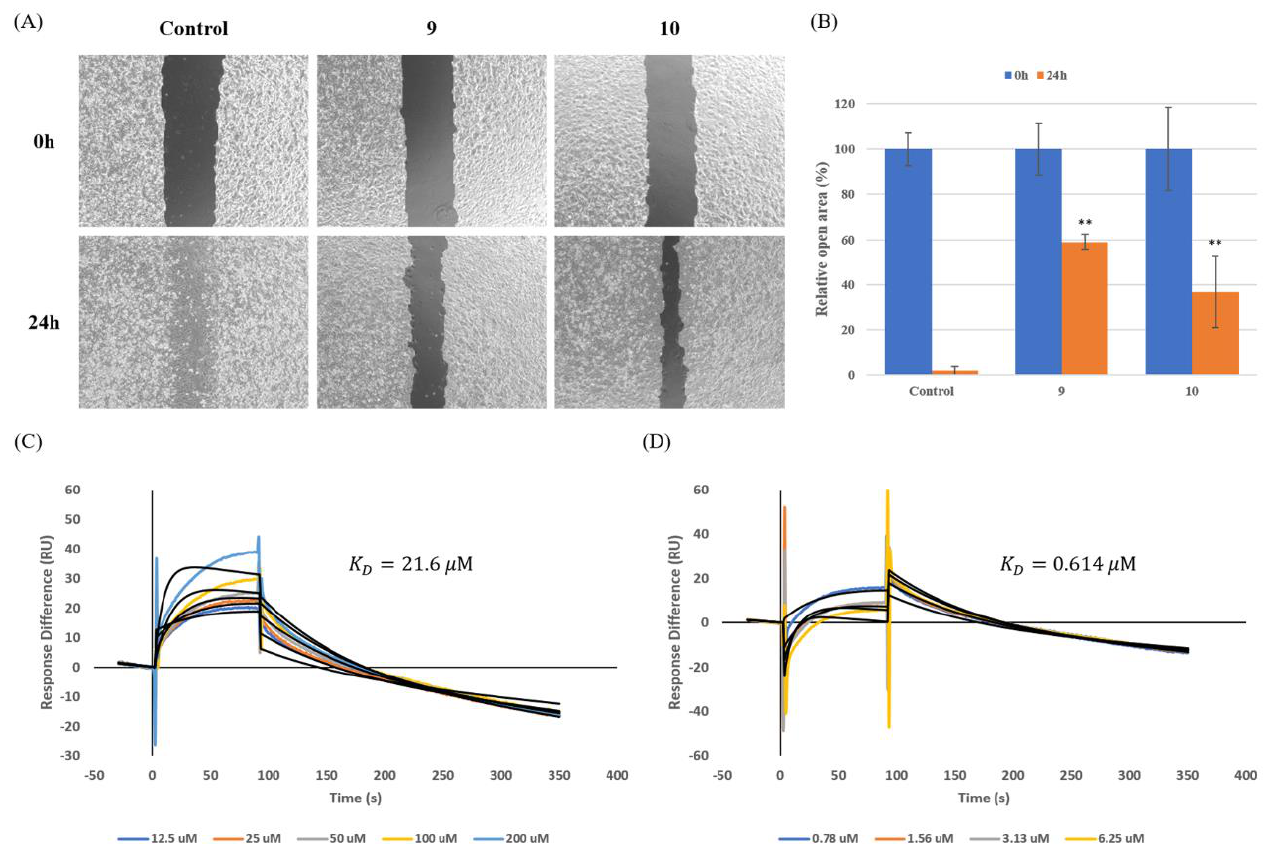
Figure 4. The inhibition of MMP-9 by compounds 9 and 10. ( A ) Wound-healing assays for A375SM cells exposed to 30 µ M for 24 h. The wounded region was observed with the TScratch program. ( B ) The results of the wound-healing assays. Columns are the mean percentage of the relative open area after 24 h compared to 0 h, and the error bars are the standard error of the mean ( n = 3). ** p < 0.01 vs. control group. ( C ) Sensorgrams of 9 binding to MMP-9. ( D ) Sensorgrams of 10 binding to MMP-9.